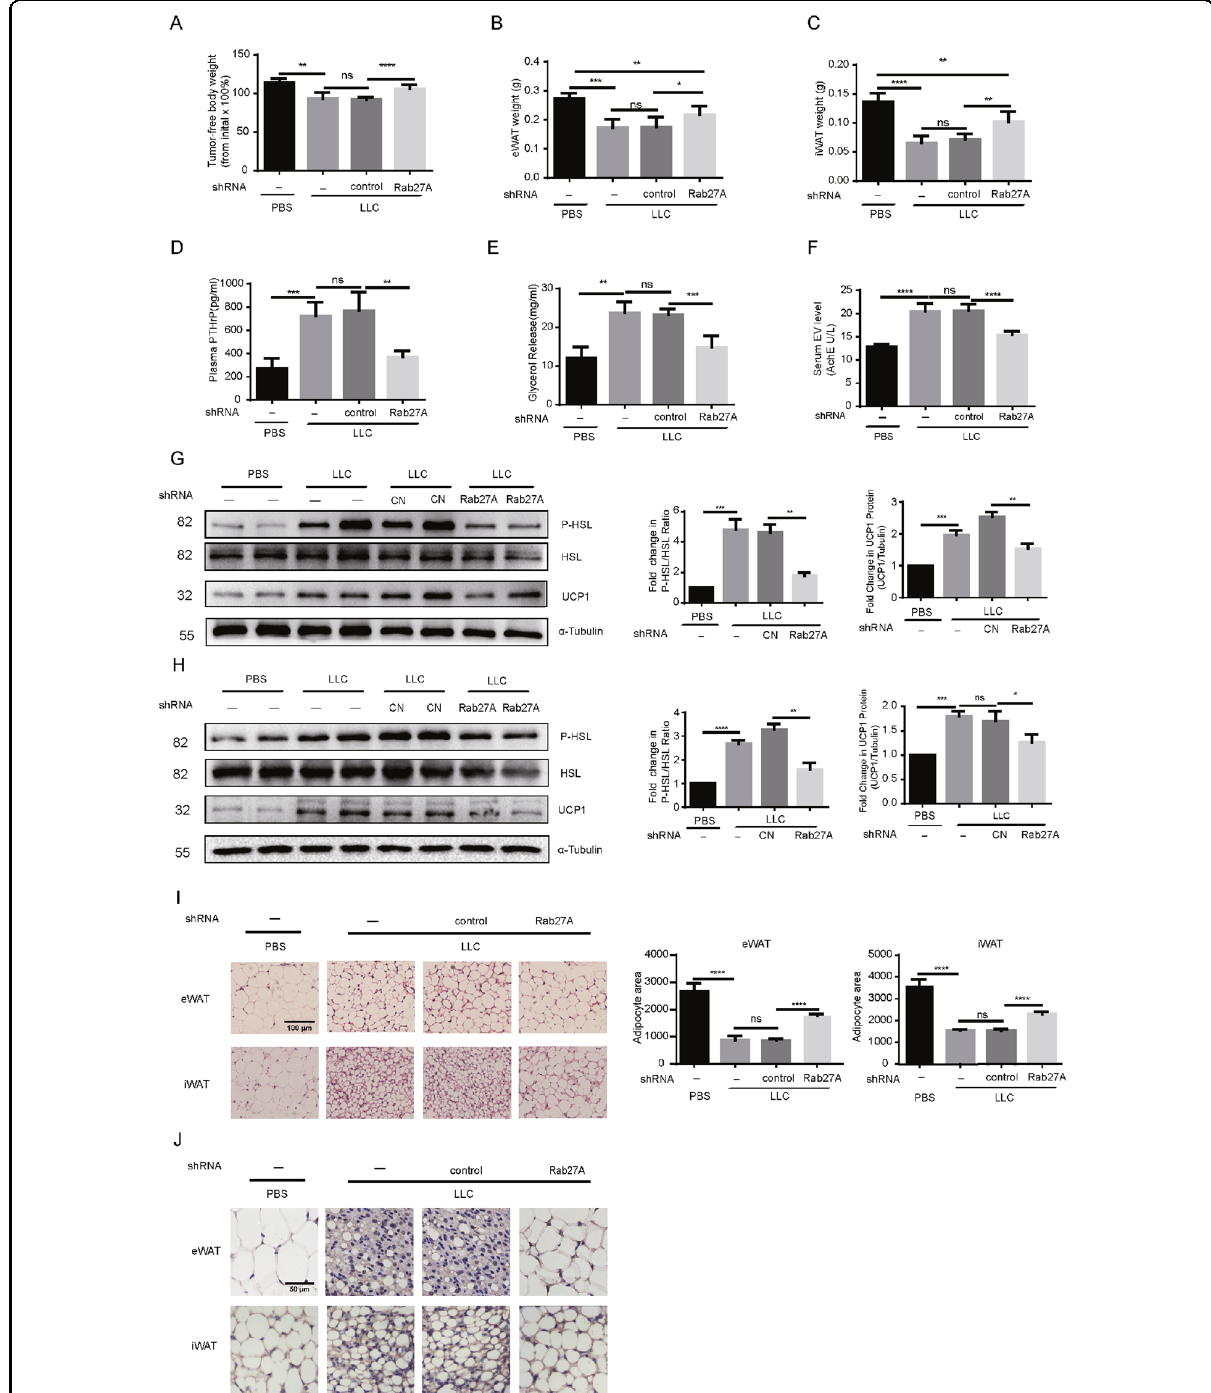
Fig. 6 Tumor-released PTHrP-expressing EVs caused lipolysis and WAT browning ( n = 9 for each group). ( A ) Weight change of the tumor-free body. Data ( n = 3) were analyzed by analysis of variance (ANOVA) ( B , C ) Weight change of iWAT and eWAT. Data ( n = 3) were analyzed by analysis of variance (ANOVA) ( D , E , F ) Level of PTHrP concentration, glycerol release, and serum AchE activity in the serum of mice. Data ( n = 3) were analyzed by analysis of variance (ANOVA) ( G , H ) western blotting analysis the level of P-HSL and UCP1 in eWAT and iWAT. Data ( n = 3) were analyzed by analysis of variance (ANOVA) ( I , J ) Hematoxylin and eosin and UCP1 staining of eWAT and iWAT. Data ( n = 3) were analyzed by analysis of variance (ANOVA). * P < 0.05, ** P < 0.01, *** P < 0.001, **** P < 0.0001, ns: not signi fi